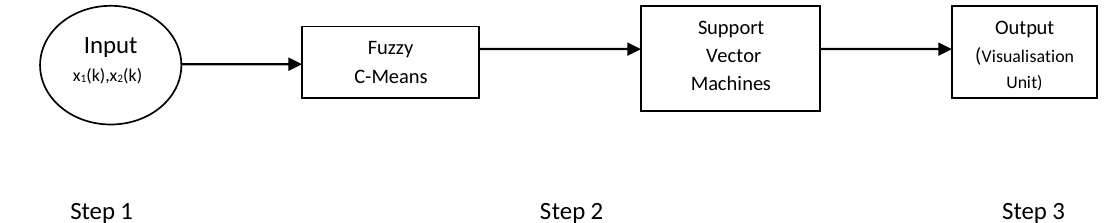
Figure 2. Block scheme for FCM and SVM combinatione.